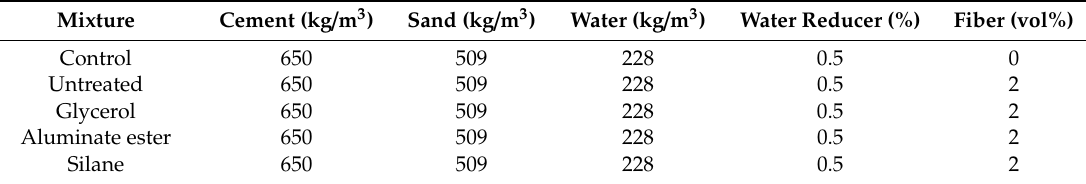
Figure 3. Sieve analysis of sand used in mortar. Table 3. Mixture